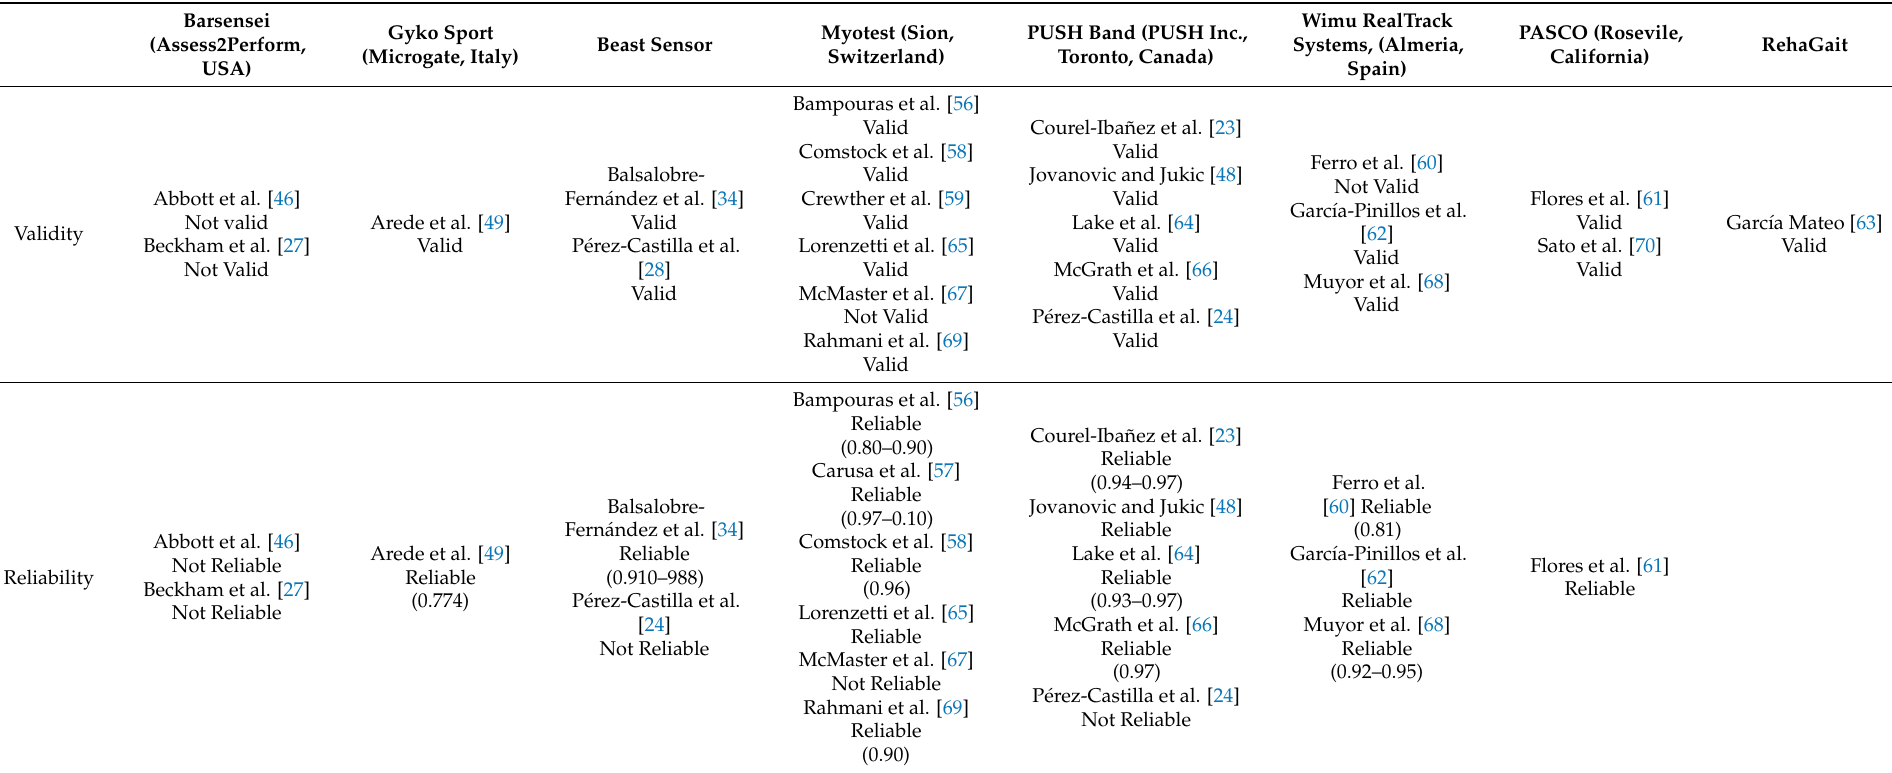
Table 6. Summary of validity and reliability of different IMU